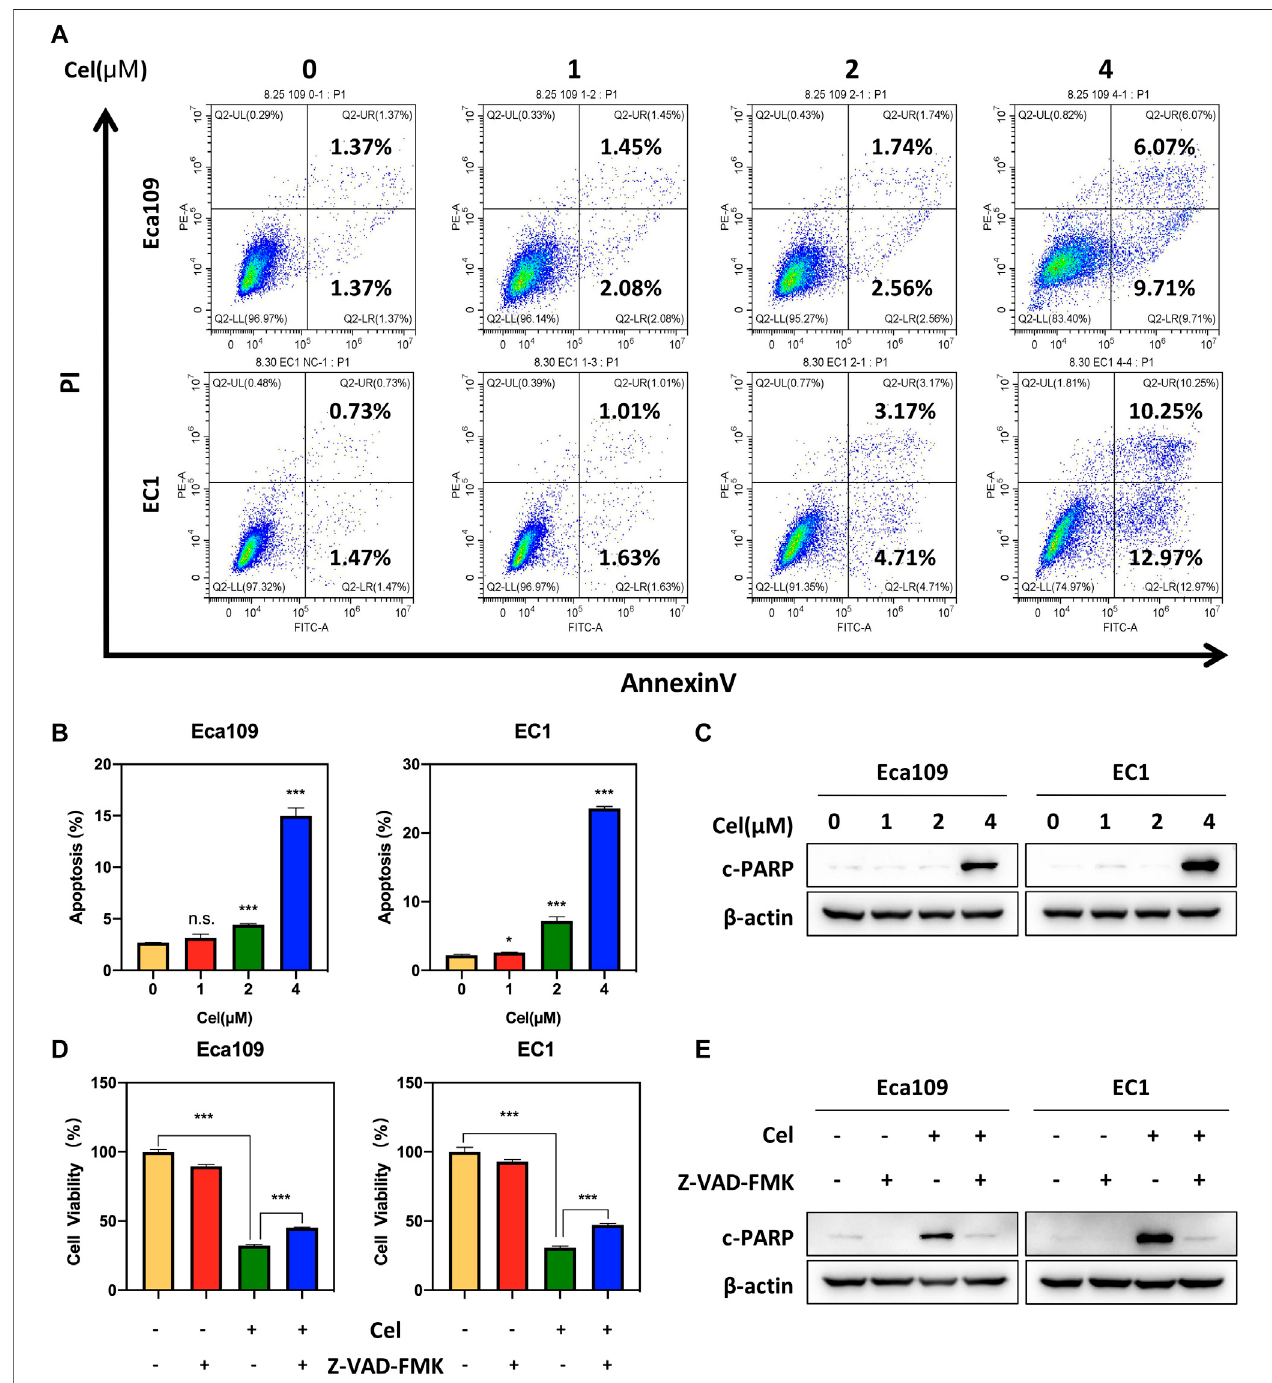
FIGURE 2 | Celastrol induced apoptosis in ESCC cells. (A,B) Eca109 and EC1 cells were treated with 1, 2, and 4 μ M of celastrol or DMSO for 24 h. And then the cells were stained with Annexin-V-FITC and PI apoptosis kit and tested by the fl ow cytometric analysis. Data were assessed with GraphPad Prism 8 software. (C) Celastrolincreasedtheexpressionlevelofc-PARP.Eca109andEC1cellsweretreatedwith1,2,and4 μ McelastrolorDMSOfor24 h,andcelllysateswereanalyzedby Western blotting with a speci fi c antibody against c-PARP with β -actin as a loading control. (D) ATPlite assay was used to determine the cell viability of Eca109 and EC1cellstreatedwithDMSO,4 μ Mcelastrol,20 μ MZ-VAD-FMK,orbothfor24 h. (E) Eca109andEC1cellstreatedwithDMSO, 4 μ Mcelastrol,20 μ MZ-VAD-FMK,or both for 24 h, and cell lysates were analyzed by Western blotting using an antibody against c-PARP with β -actin as a loading control. p denotes p < 0.05, ppp denotes p < 0.001, n.s. denotes not signi fi